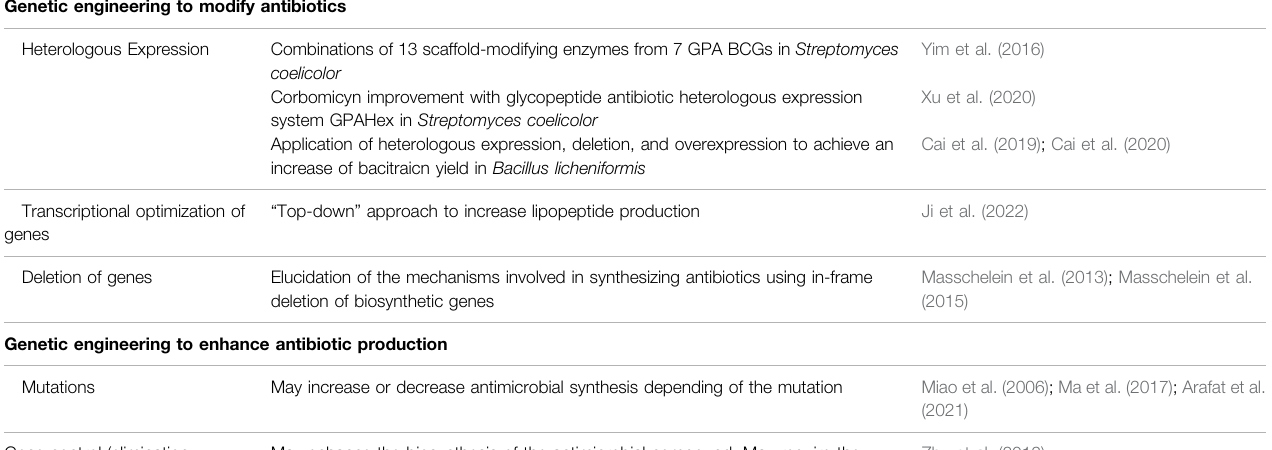
TABLE 1 | Synthetic biology tools to fi ght antibiotic resistance using genetic engineering to modify antibiotics and enhance antibiotic production, engineered phages, and microbial control